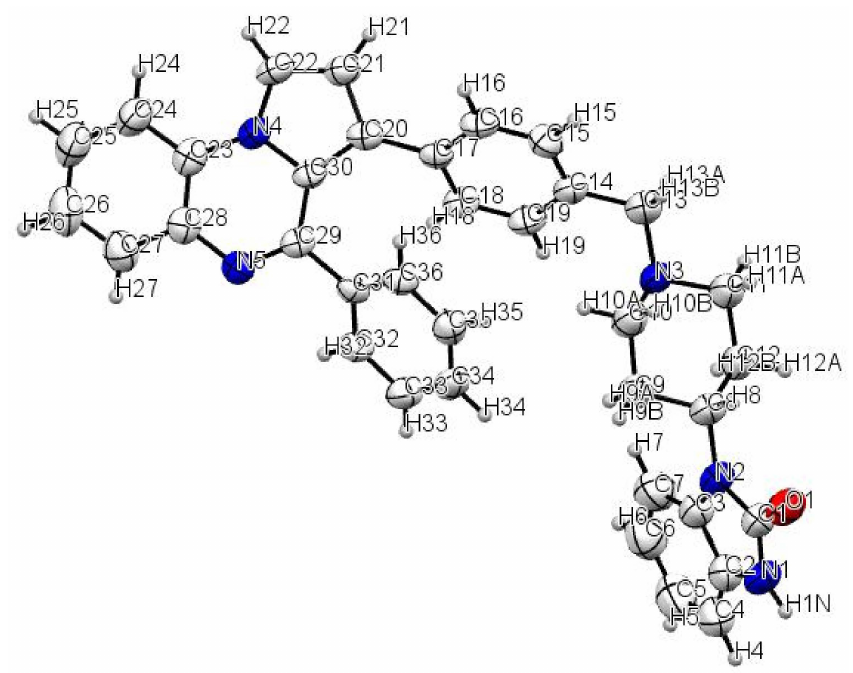
Figure 2. The ORTEP (Oak Ridge Thermal Ellipsoid Plot) drawing of the 1,3-dihydro-1-{1-[4-(4- phenylpyrrolo[1,2- a ]quinoxalin-3-yl)benzyl]piperidin-4-yl}-2 H -benzimidazol-2-one ( 9 ) with thermal ellipsoids at a 30%